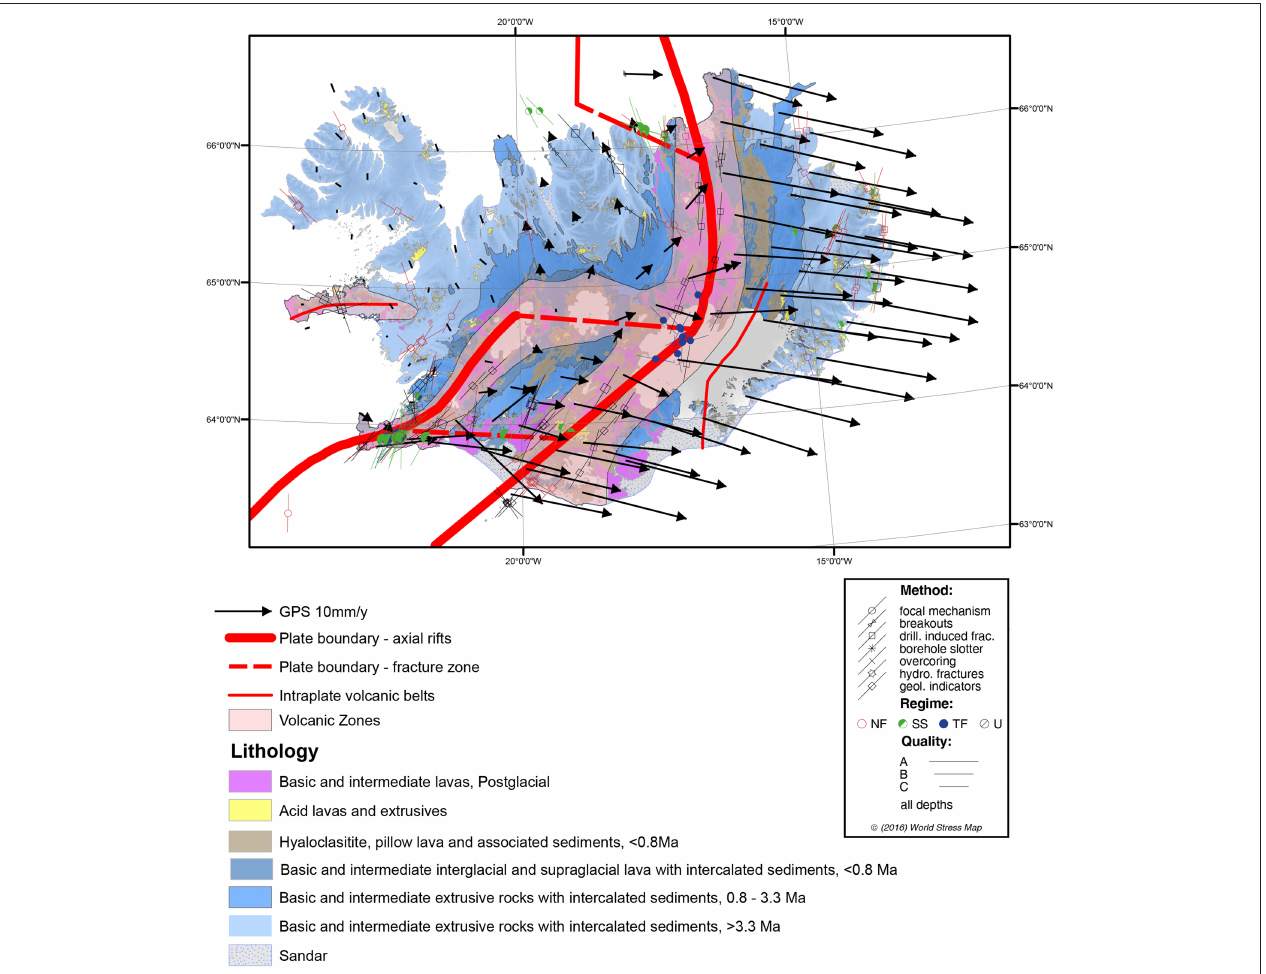
FIGURE 10 | Geological map of Iceland including main fault strucutres and volcanic belts. RR, Reykjanes Ridge; RP, Reykjanes Peninsula; RVB, Reykjanes Volcanic Belt; WVZ, EVZ, and NVZ, Western, Eastern and Northern Volcanic Zone; TFZ, Tjörnes Fracture Zone; Thv, Thingvellir. Geological map modified after Jóhannesson (2014). Rift zones from Thordarson and Larsen (2007), GPS data from Árnadóttir et al. (2008), stress data from Heidbach et al. (2016).